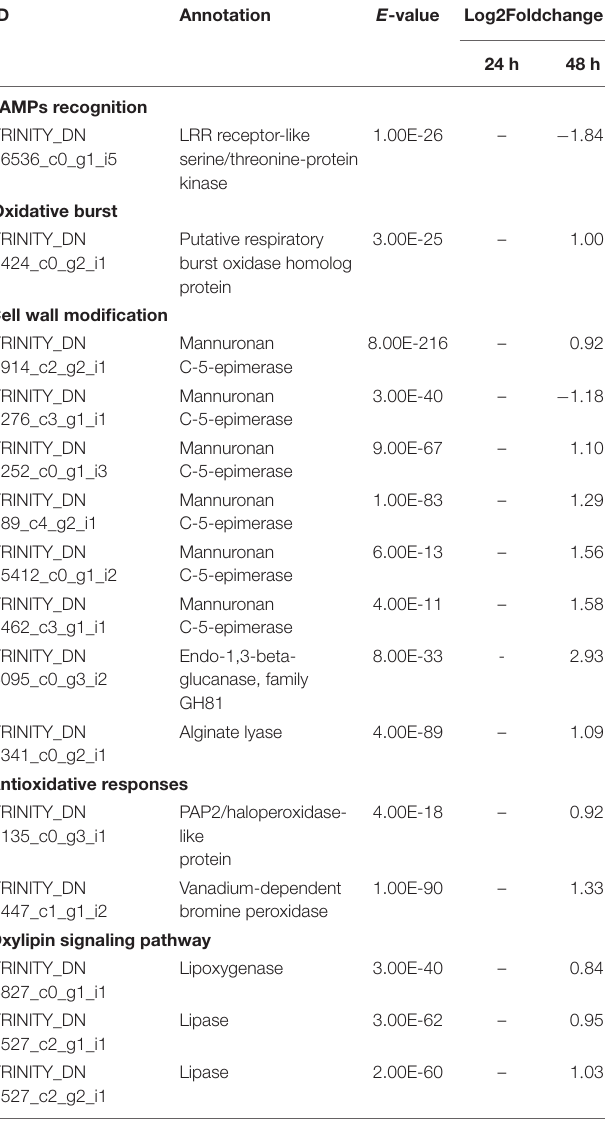
TABLE 2 | Selected significant differentially expressed genes (DEGs) in L. digitata after co-cultivation with L. elsbetiae for 24 and 48 h vs. the control group (q ≤ 0.01, | log2 FC| ≥ 0.7).